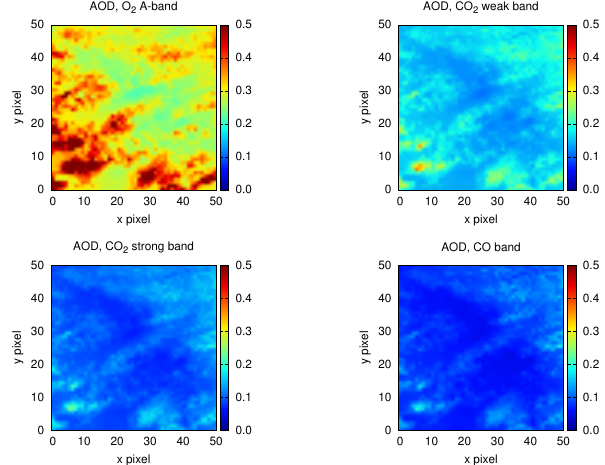
Figure 3. Aerosol optical depth over Shanghai on 8 September 2010 at 08:15UTC in the geoCARB spectral bands. The horizontal and vertical axes are labelled by geoCARB frames and